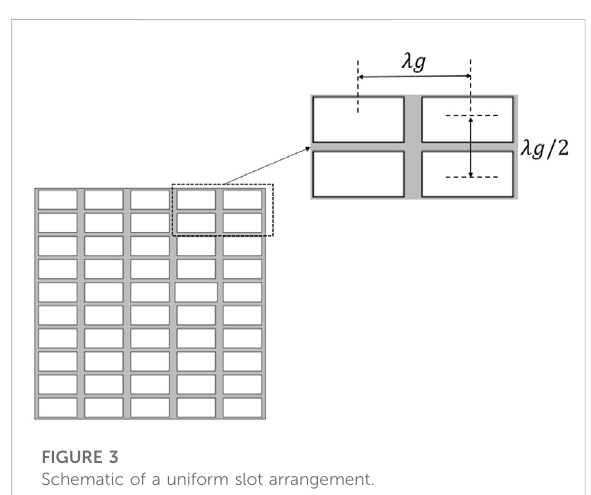
TABLE 1 Material parameters.